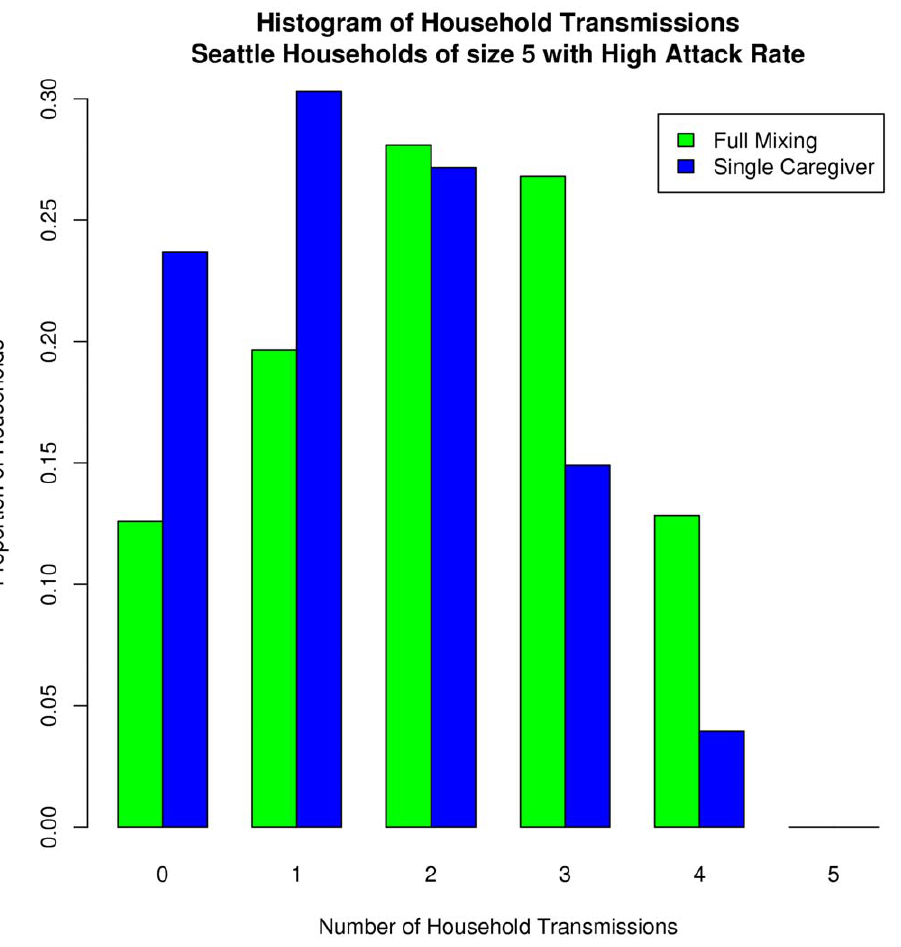
Figure 5. The distribution of infections within Seattle households of size 5. Under full mixing conditions more households experience higher transmissions within the household. In case of the single caregiver model a majority of households experience fewer than two transmissions within the household, predominantly the caregiver.